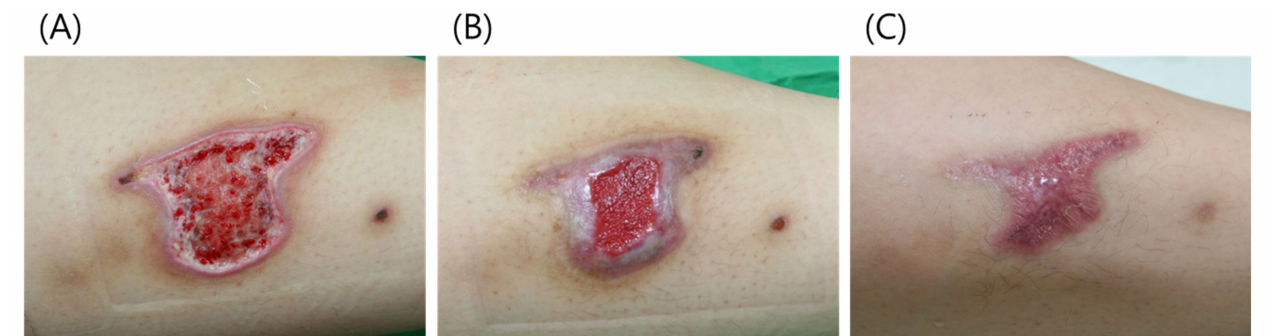
Figure 6. ( A ) A 27-year-old female patient presented with a third-degree contact burn on her lower left leg. ( B ) After 4 weeks, the wound size had reduced by approximately 50%. ( C ) At week 12, the wound had healed completely.